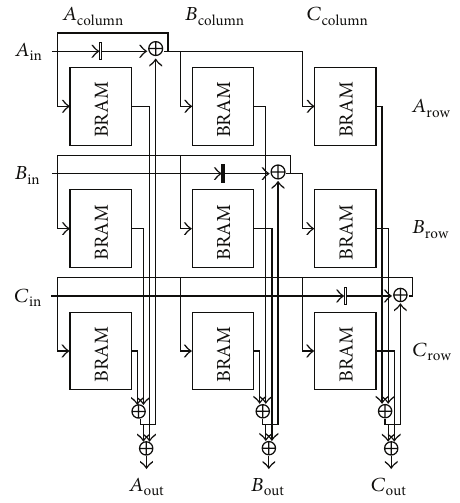
Figure 1: This XOR memory has 3 ports. 𝐵 in and 𝐵 out are part of the same port. Port 𝐵 controls the address of each BRAM’s read port in 𝐵 column and each BRAM’s write port in 𝐵 row . Writing to memory using port 𝐵 requires reading from BRAMs in 𝐵 column (except the one in 𝐵 row ) as well as writing to the BRAMs in 𝐵 row . Reading from memory requires reading from all the BRAMs in 𝐵 column . Because the same read port on the BRAMs is used for reading and writing to the memory, it is not possible to split port 𝐵 into a read-only port and a write-only port as it is with LVT.